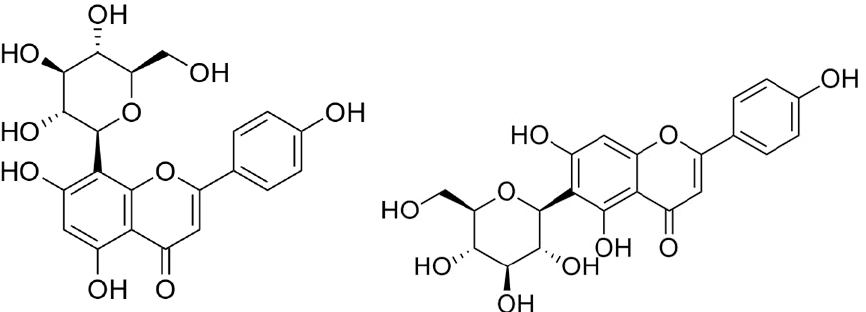
Figure 3. Chemical structure of vitexin ( left ) and isovitexin ( right ).